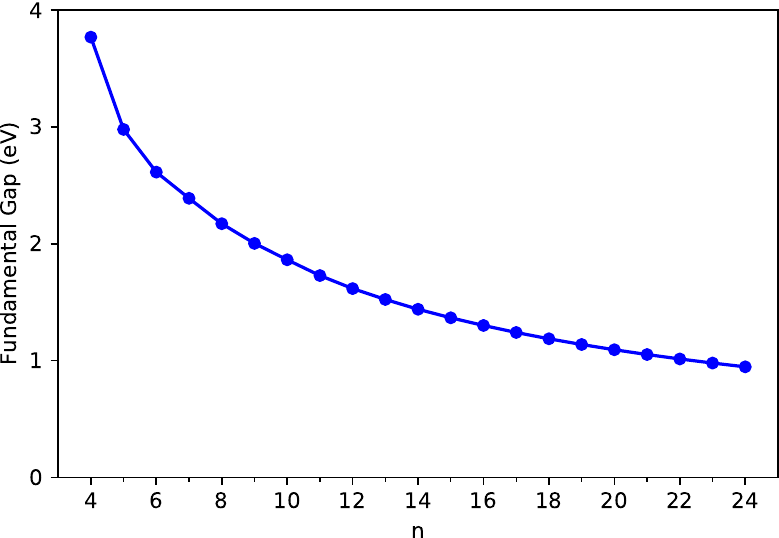
Figure 5. Fundamental gap of ground-state C-Belt[ n ], computed using spin-unrestricted